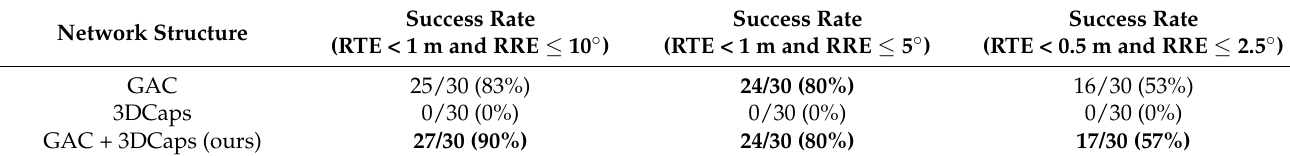
Table 8. Contrastive analysis of descriptor extraction networks in Dataset II.